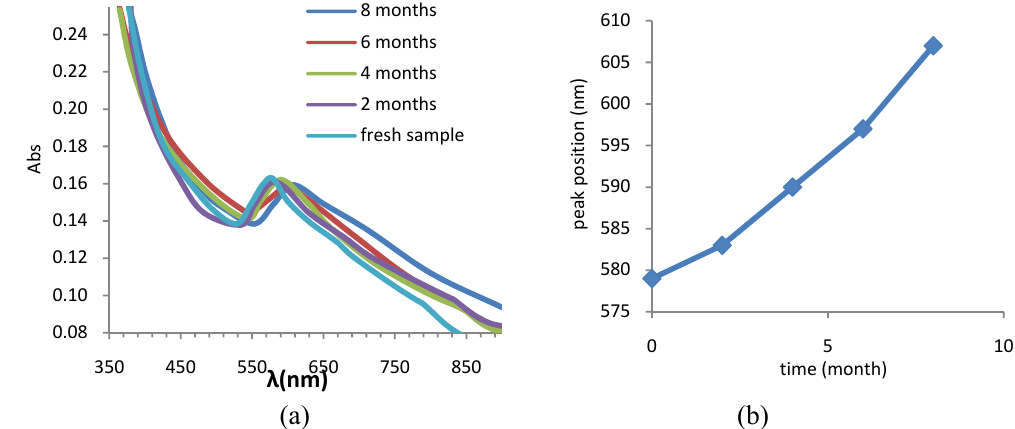
Fig. 5: (a) Optical absorption spectra of Cu nanoparticles synthesized by EEW in Ethylene Glycol with diam. 0.3 mm and charged voltage 250 Voltand (b) The relation between the peak position and the